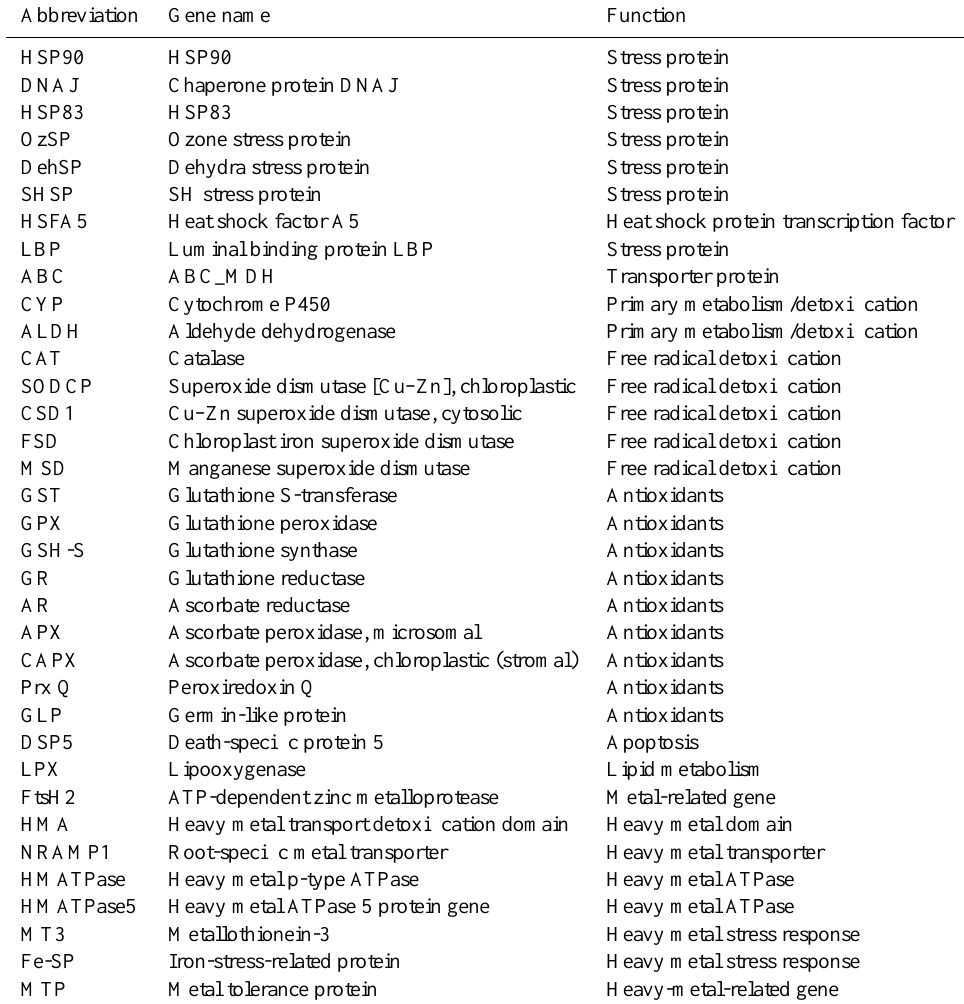
Table 1. List of selected genes of interest, with their abbreviations and